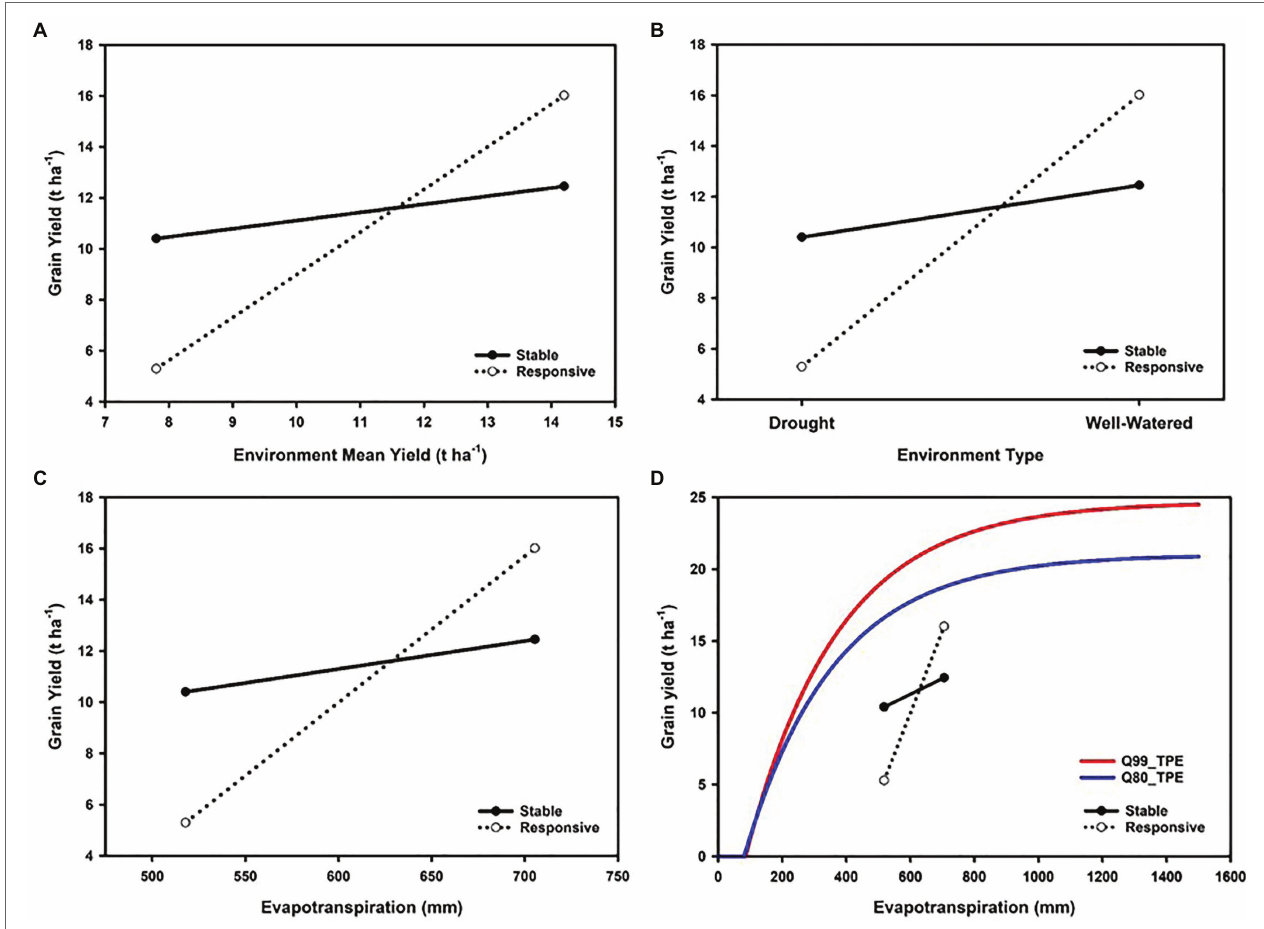
FIGURE 1 | Enviromics progression from (A) coarse-grained to (D) fine-grained characterization of environmental gradients for a maize multi-environment trial (MET) to assist interpretation of grain yield genotype-by-environment (GxE) interactions and genotypic variation for reaction-norms: (A) environments distinguished on mean grain yield of all genotypes tested (e.g., Finlay and Wilkinson, 1963), (B) environments distinguished on levels of water inputs; water-limited (drought) versus water-sufficient (well-watered), (C) environments distinguished on levels of water availability quantified as whole season crop evapotranspiration, (D) environments distinguished on evapotranspiration and considered in relation to the modelled 99th percentile and 80th percentile yield-evapotranspiration fronts for modelled genotype-by-environment-by-management (GxExM) scenarios for the US corn-belt following the methodology of Cooper et al.